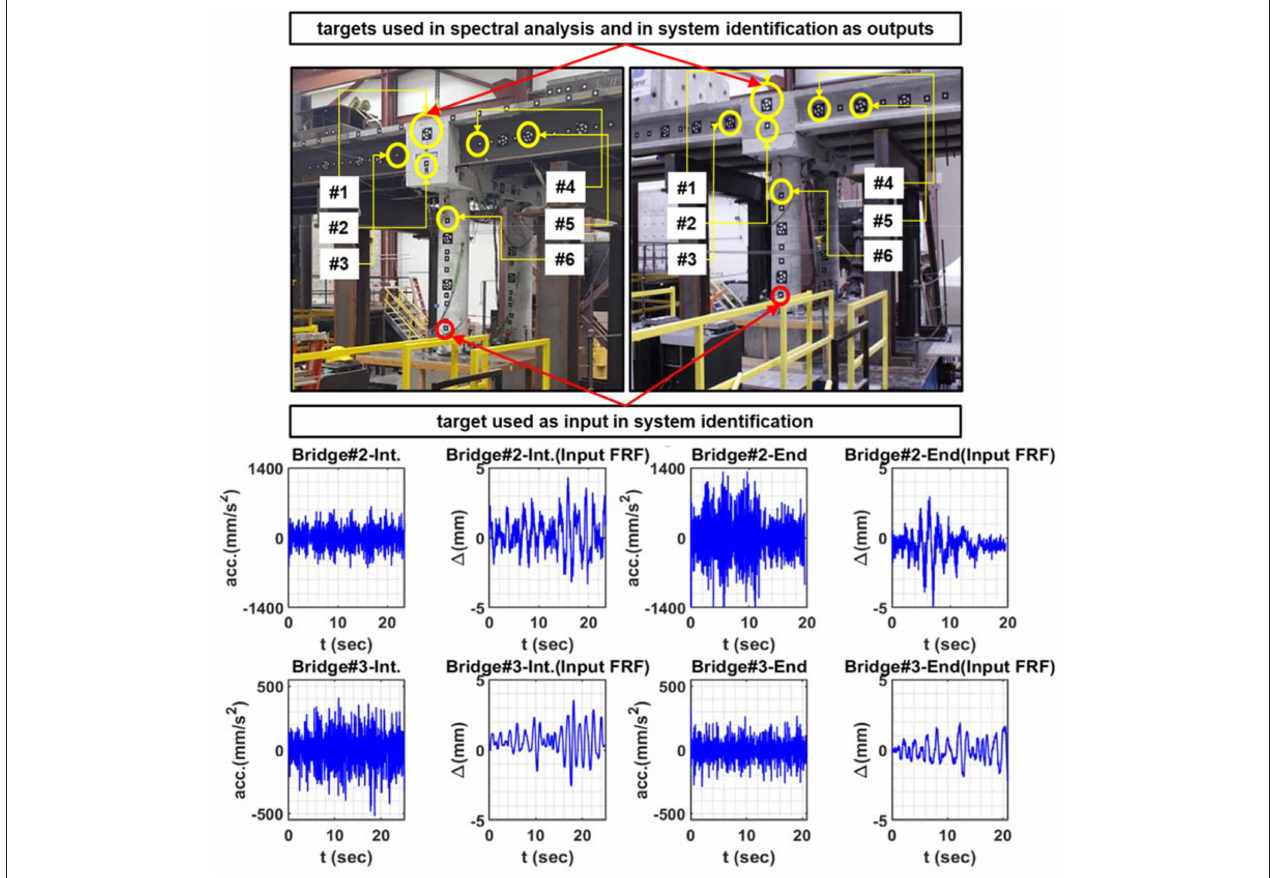
FIGURE 6 | DIC target locations on Bridge #2 and Bridge #3 used in spectral analysis and system identification (top); sample acceleration (output, target #1) and displacement signals (input) obtained for initial and end states of the bridges (bot).